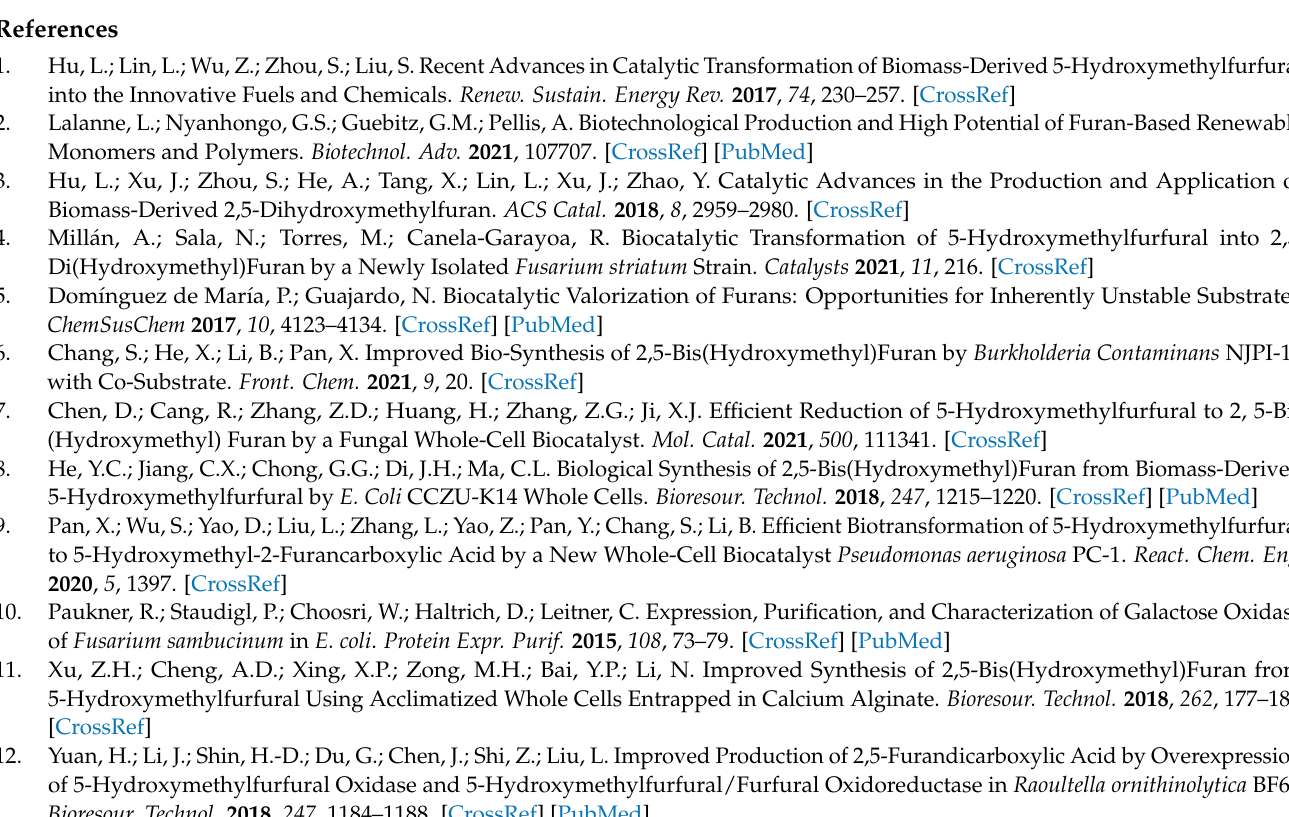
Neutrase 0.8 L; Figure S3: Fusarium striatum growth in Petri dishes containing different culture media after 3 and 6 days; Figure S4: Cultural and morphological characters of F. striatum after 10 days in different culture media; Table S1: CCD for the enzymatic hydrolysis of PDF fraction with enzyme Neutrase 0.8 L; Table S2: Analysis of variance (ANOVA) for the response surface quadratic model; Table S3: Effect test of the independent variables and their interactions; Table S4: Proximate elemental composition of fines , PDF, freeze-dried hydrolysates, and precipitates based on DM; Table S5: Amino acid composition (mg amino acid/g sample) and total amino acid content expressed as mean ± SD. References [63–65] are cited in the supplementary